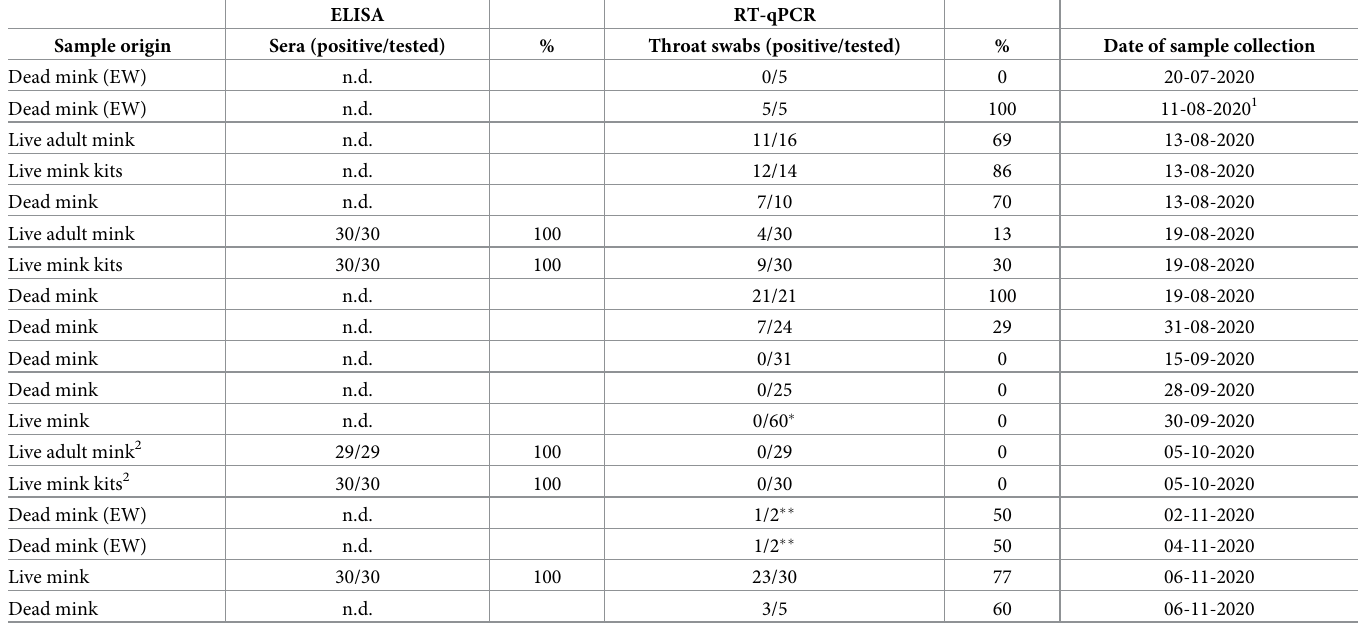
Table 1. Summary of laboratory analysis of mink sampling from Farm